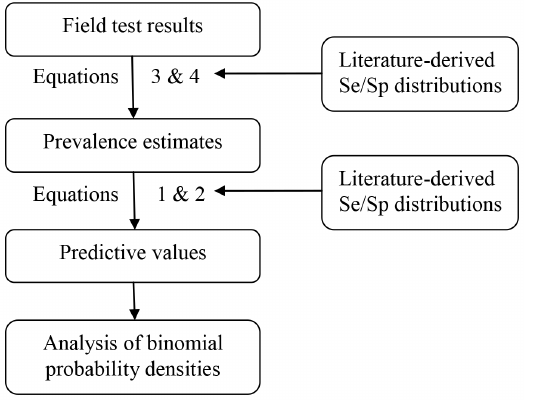
Figure 3. Algorithm of analyses performed on data from three example herds.